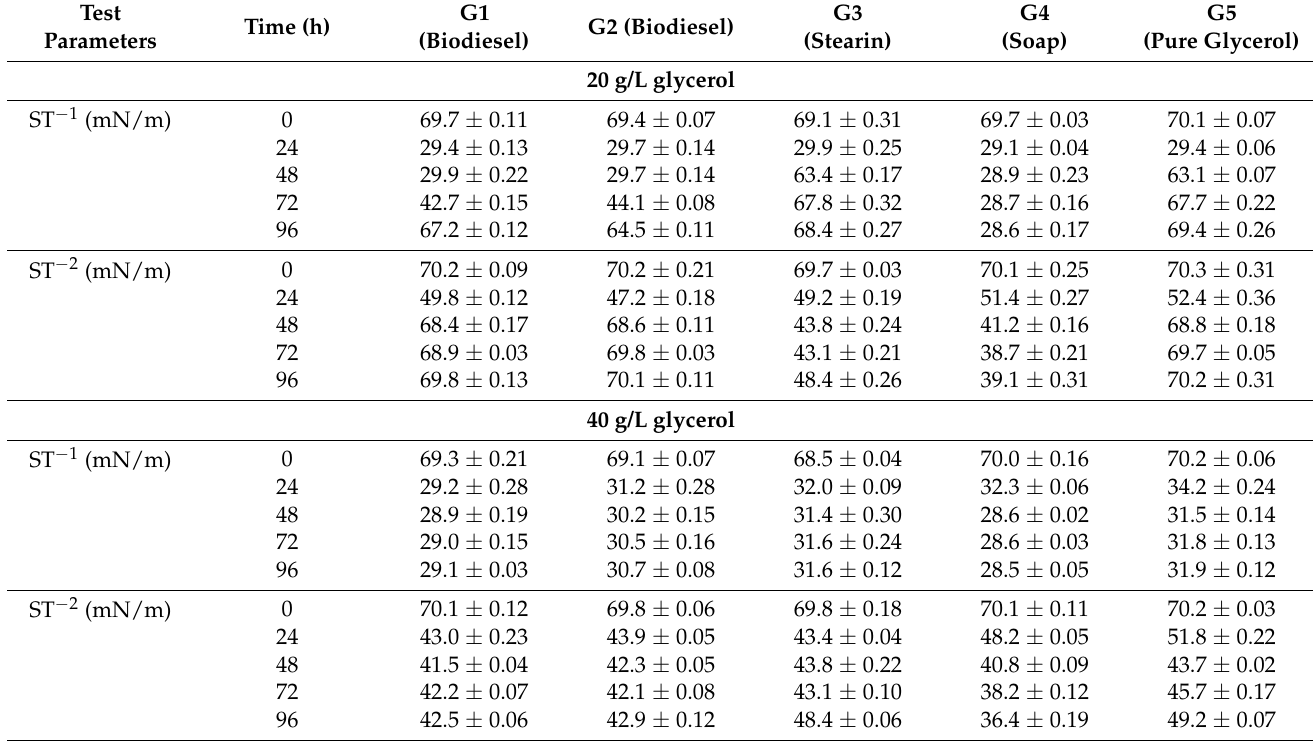
Table 1. Surface tension values [ST − 1 and ST − 2 (mN/m)] obtained for the cell-free supernatants of cultures of Bacillus subtilis #309 grown in MSM supplemented with 20 and 40 g/L of different waste glycerol samples and pure glycerol. The culture broth supernatants were diluted 10 times (ST − 1 ) or 100 times (ST − 2 ) with distilled water, and the surface tension was measured as described in Materials and Methods. The cultures were performed at 37 ◦ C and 160 rpm for 96 h. The results represent the mean ± standard deviation of three independent experiments performed in